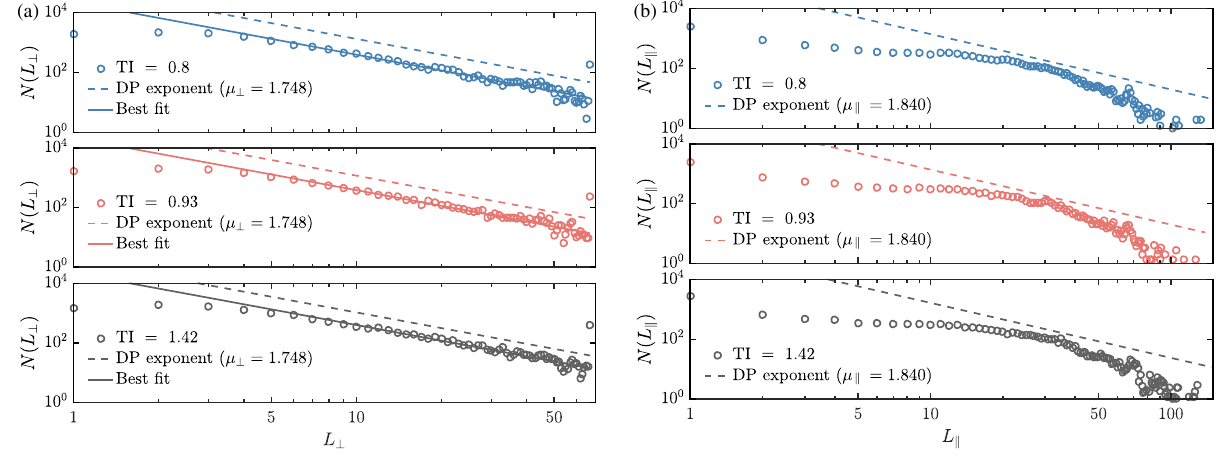
FIG. 6. (a) Size distribution of laminar clusters in space at the estimated critical Reynolds number, i.e., consecutive laminar states when sweeping in the y direction at a given time t , for three illustrative values of turbulence intensity thresholds and (b) their corresponding size distribution of laminar clusters in time, i.e., consecutive laminar states when sweeping in the time t while keeping y constant. Solid lines show the theoretical distribution predicted by the directed percolation model at the transition. For comparative purposes, the turbulence intensity threshold values are the same as the ones in Fig. 4(b), where the critical value for each TI is given. Cluster lengths are shown in multiples of the spatial and temporal resolution, respectively.